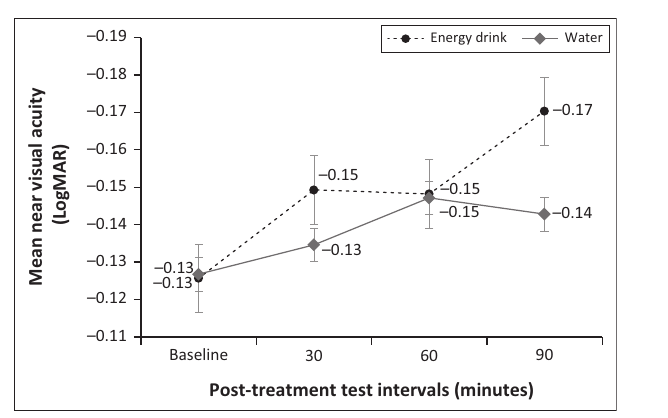
FIGURE 1 : Time courses of mean near visual acuity at baseline and at 30 min, 60 min and 90 min post-treatment with 250 mL energy drink or water.